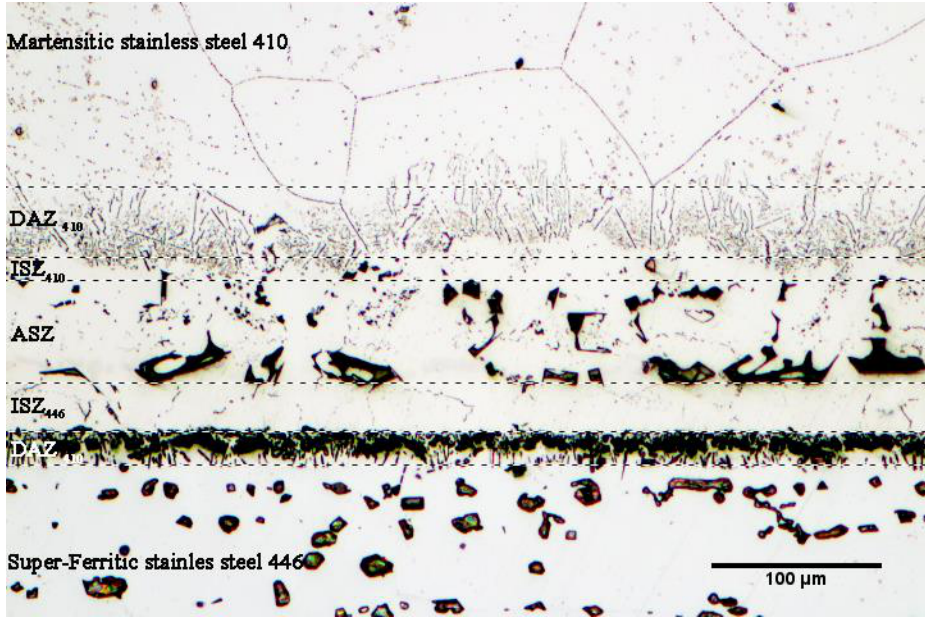
Figure 5. The optical microscopy of TLP-bonded sample at 1050 °C/1 min